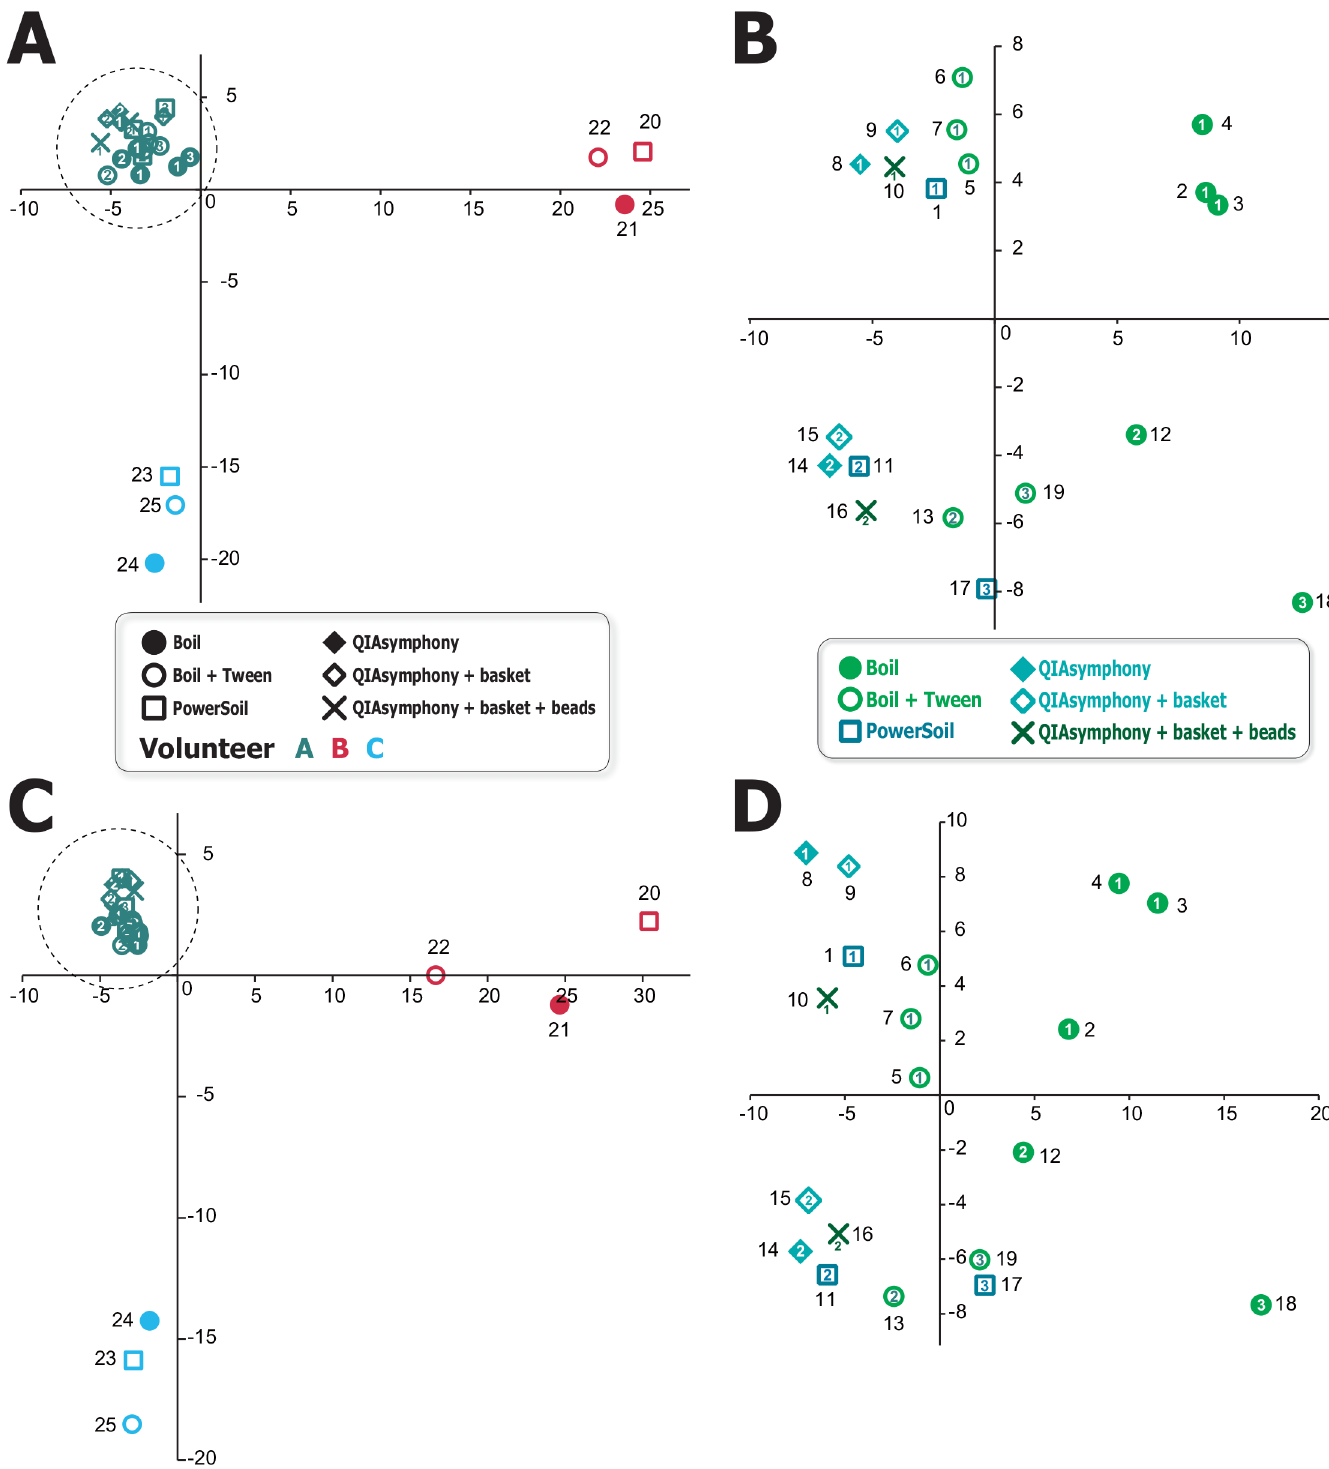
Fig 3. 2D plot resulting from principal component analysis. A) Plot based on logarithm-converted values for the 25 samples. B) Plot based on the 19 samples from volunteer A enclosed by the dashed circle in panel A. C) Plot based on linear values for the 25 samples. D) Plot based on the 19 samples from volunteer A enclosed by the dashed circle in panel C. Horizontal and vertical axis represent PC1 and PC2, respectively. Sampling day numbers of volunteer A are shown as numerals.